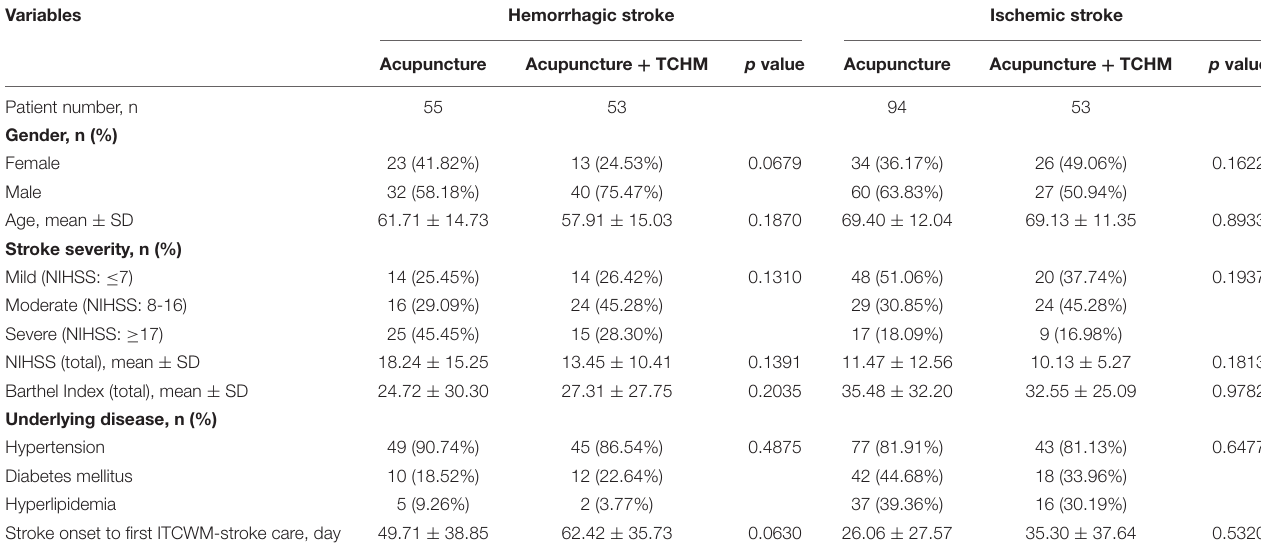
TABLE 1 | Baseline demographic and clinical characteristics.